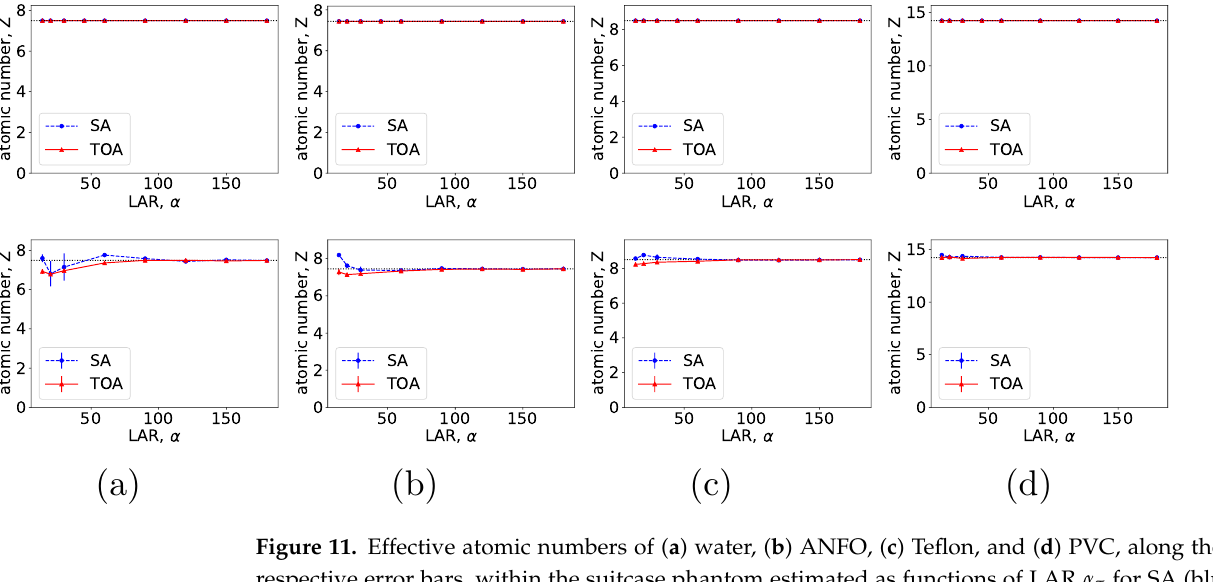
Figure 10. Metrics nRMSE and PCC, computed over VMIs of the suitcase phantom from noiseless data in Figure 9 (row 1) and those from noisy data in Figure 12 (row 2) as functions of LARs α τ for SA (blue, dashed) and TOA (red, solid) scans. The horizontal lines (black, dotted) indicate the reference values from FAR data of 360 ◦ .